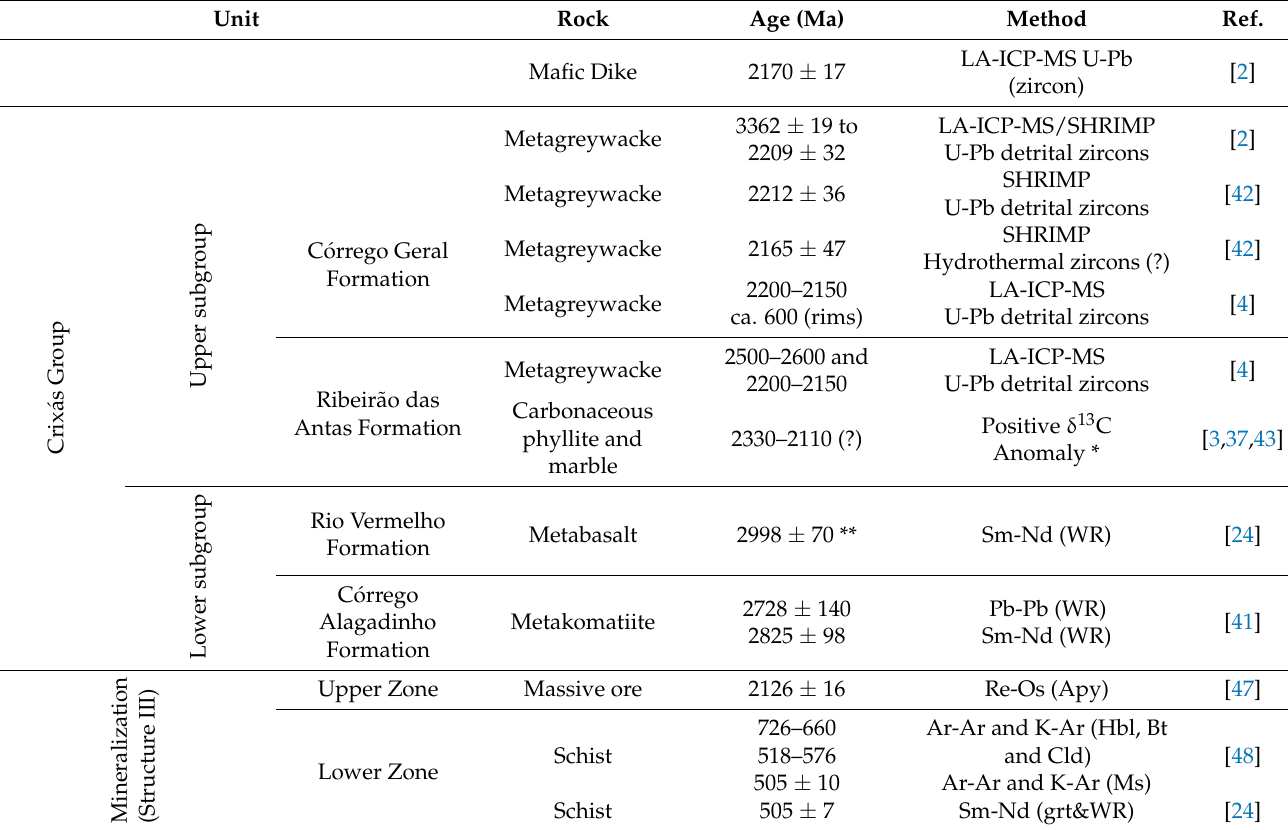
Table 2. Summary of geochronological results. * positive δ 13 C anomalous values of +5.3‰ to +14‰ (PDB) interpreted as related to the worldwide Lomagundi Event. ** age from a mixture of metakomatiite and metabasalt samples results. WR—whole rock, aspy—arsenopyrite, amph—amphibole, bt—biotite, cld—chloritoid, ms—muscovite, grt—garnet. Unit Rock Age